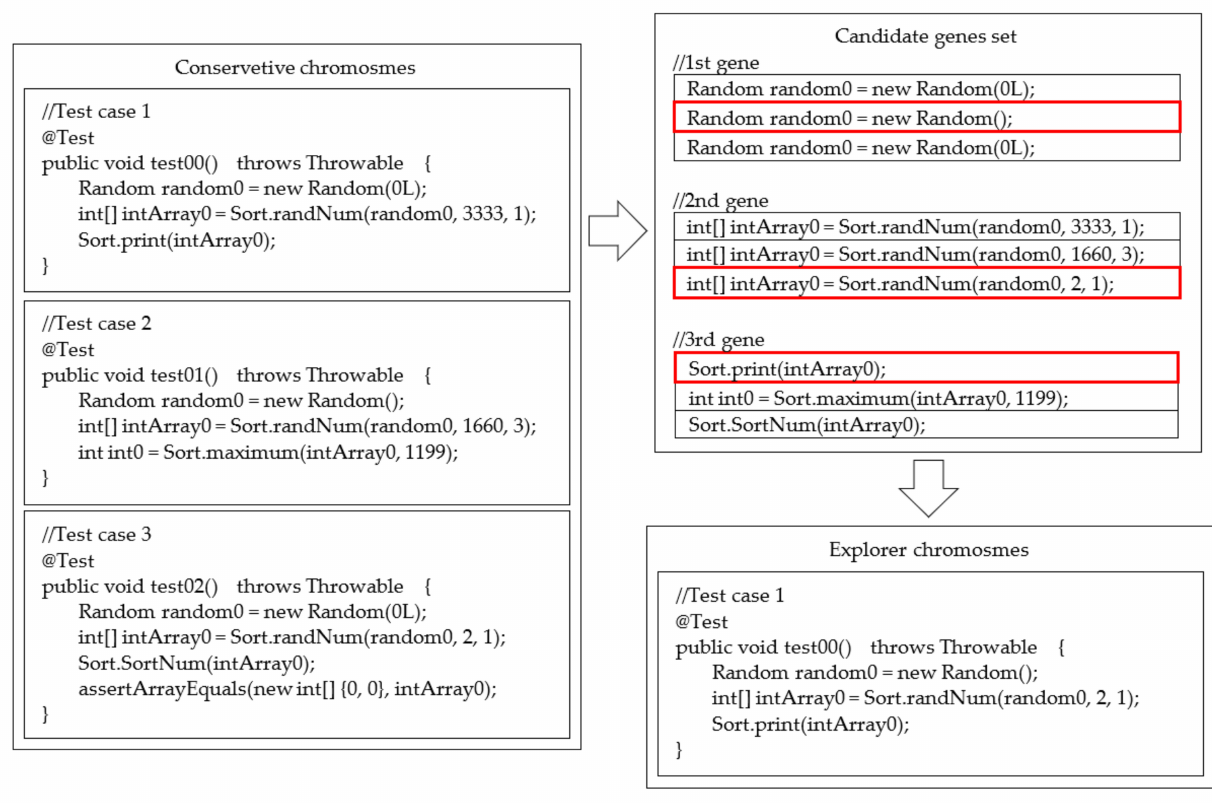
Figure 3. Mechanism of creating explorer chromosome. Red boxes demonstrate which one gene from each candidate gene set was